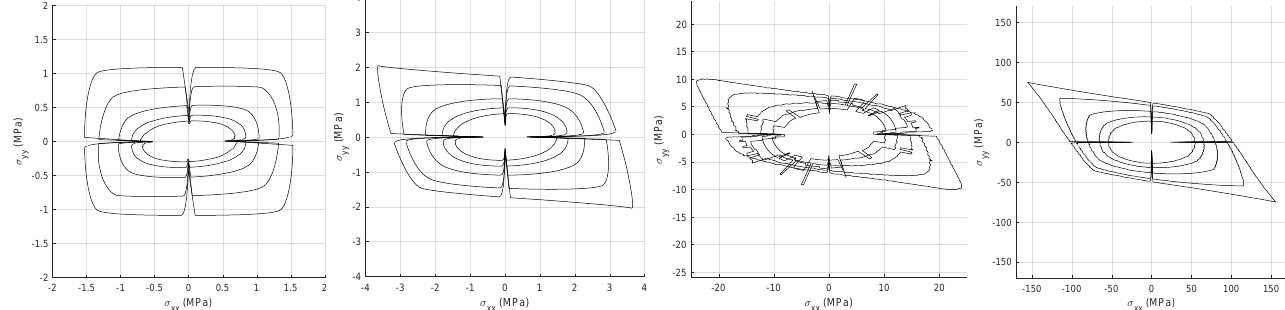
Figure 5. Failure envelopes for different crack stiffnesses, maximum stress failure criterion. Respectively from left to right G = 10 12 Pa–10 13 Pa–10 14 Pa–10 15 Pa. The concentric envelopes correspond to different applied macro shear. The macro shear spans from zero, for the outmost envelope, until 0.200 for the innermost, with an increment of 0.040.